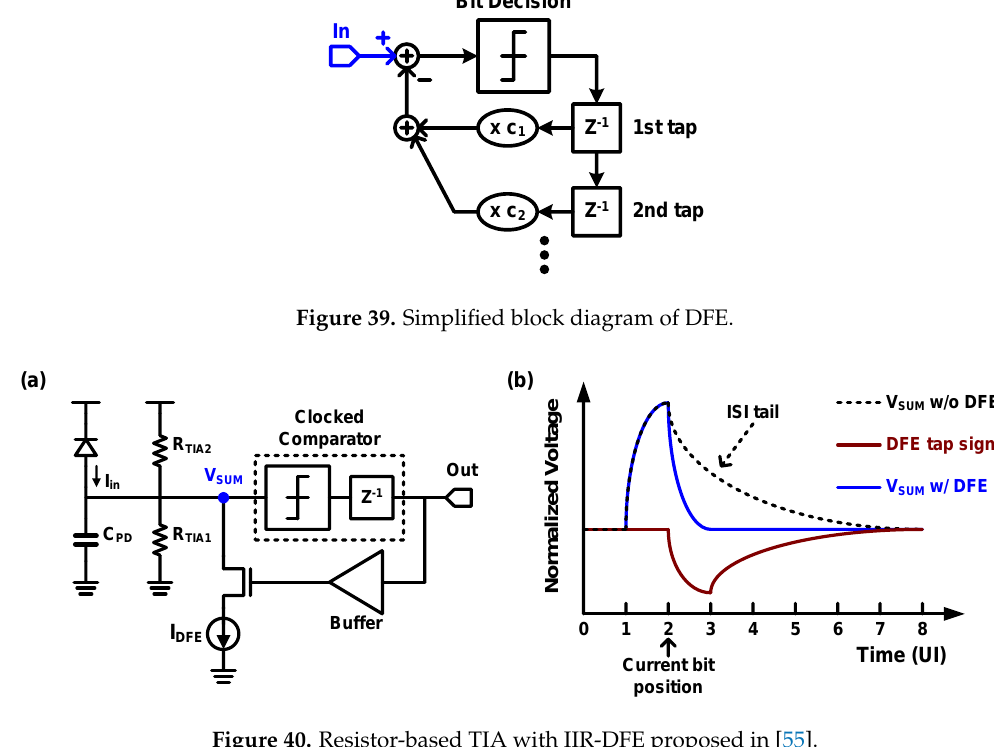
Figure 40. Resistor-based TIA with IIR-DFE proposed in [55].